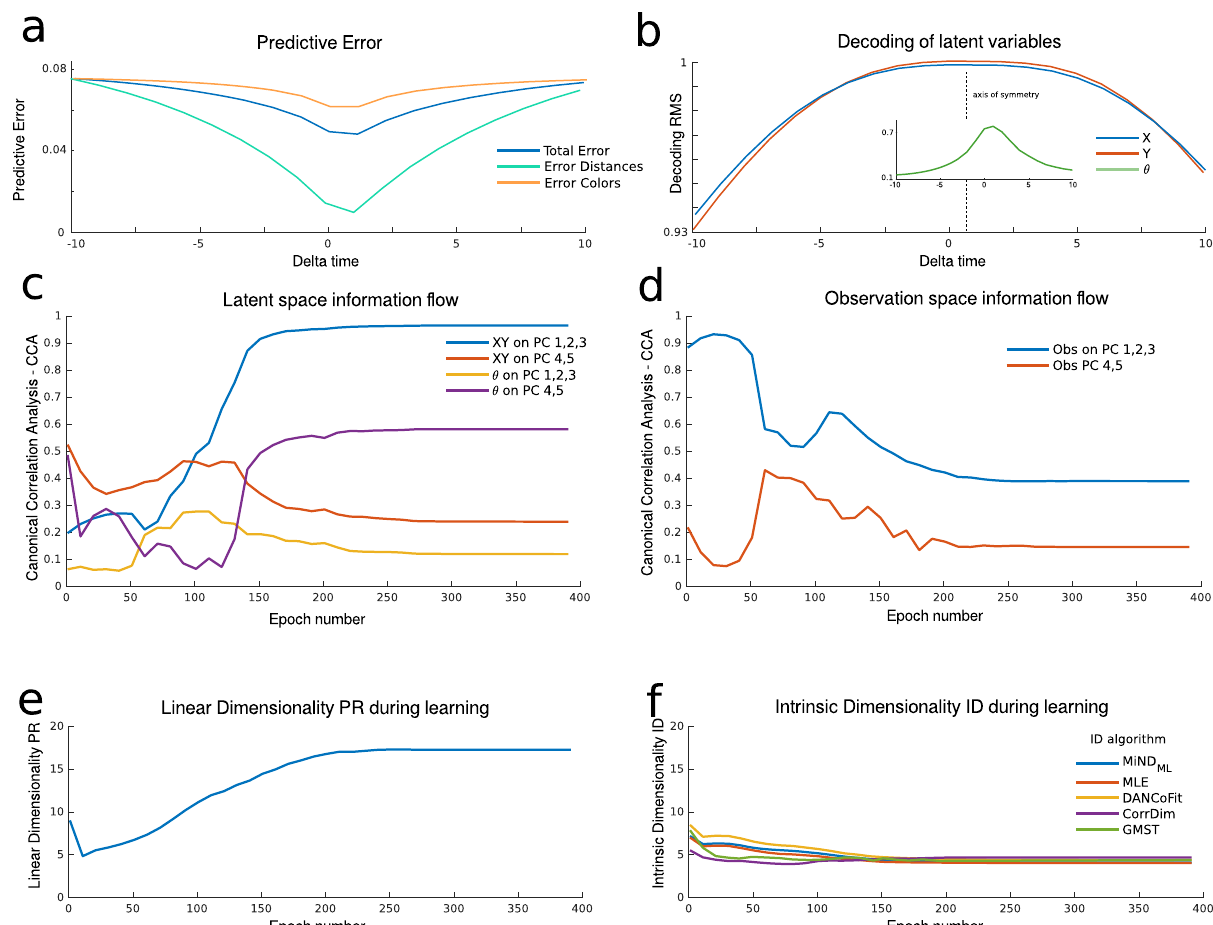
Fig. 3 Learning the predictive representation. a Predictive error ( L 2 norm) in blue between the network ’ s output and the observation as a function of the lag (Delta t ). In red average L 2 norm between the observation at time 0 and at a lag Delta t . b Linear decoding of latent variables. RMS measure of the linear decoding of ( x , y , θ ) at time Delta t from the neural representation at time 0. The dotted line highlights the axis of symmetry of the curves. c Signal transfer analysis: Canonical Correlation Analysis between PCs of the neural representation and the latent space. The lines correspond to the average of the canonical correlations between the highlighted variables. d Same as panel c but for the observation space. e Participation ratio of the representation during learning. f Intrinsic dimensionality (ID) of the representation during learning. Five different intrinsic dimensionality estimators are used (cfr.